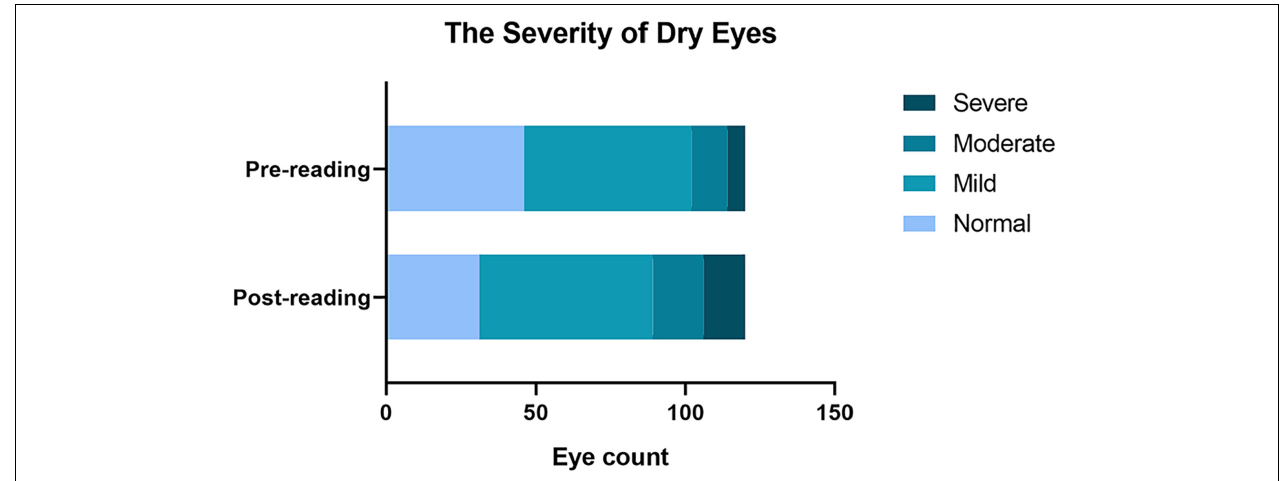
FIGURE 1 | Effects of continuous reading for 2 h with smartphones in the diagnostic rate of dry eye and the severity of dry eyes. A significant increase in the total diagnostic rate of dry eye. The diagnosis rate from mild dry eye to moderate and severe eye was significantly increased compared to that before the reading test.